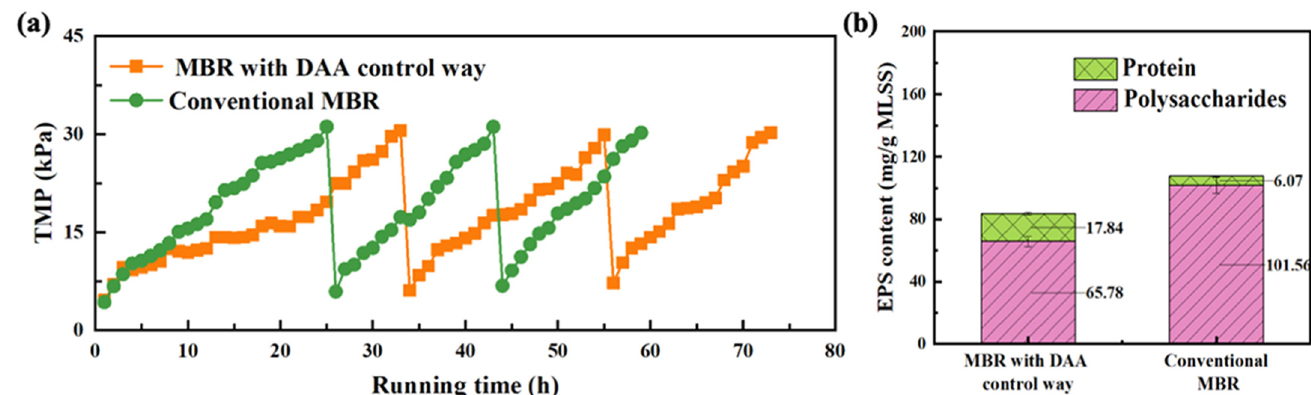
Figure 2. Evolvement profiles of membrane biofouling extent of MBR with DAA control way and conventional MBR. ( a ) TMP variation with running time for MBR with DAA control way and conventional MBR for three cycles. ( b ) Comparison of EPS production content between MBR with DAA control way and conventional MBR.